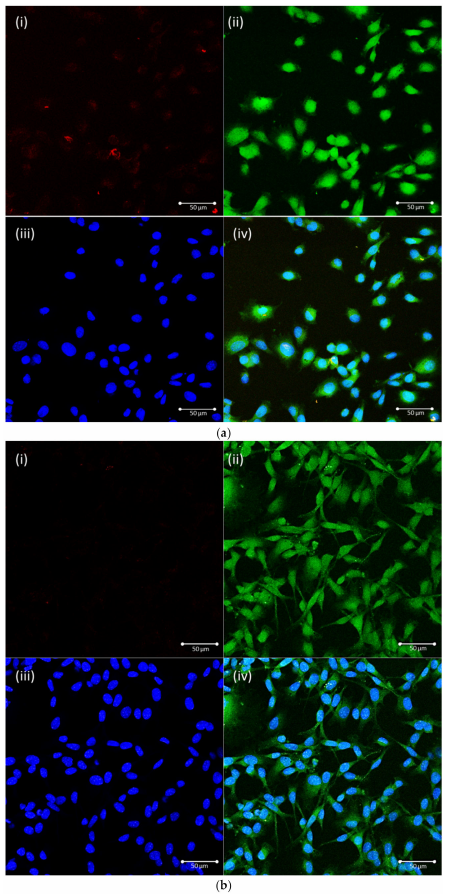
Figure 4. Cellular uptake evaluated for GNC-PLGA/APP NPs in D1 cells. Culture conditions without inhibitor ( a ) and with the inhibitor of hypertonic sucrose solution ( b ). Cellular uptake in D1 cells (a bone marrow-derived mesenchymal stem cell line) was incubated with GNC-PLGA/APP NPs for 10 min. Red: GNC-PLGA/APP NPs ( i ); green: FITC-labeled cell cytoplasm ( ii ); blue: DAPI-stained cell nucleus ( iii ). Overlapping images ( iv ) from ( i ), ( ii ), and ( iii ). Scale bar = 50 µ